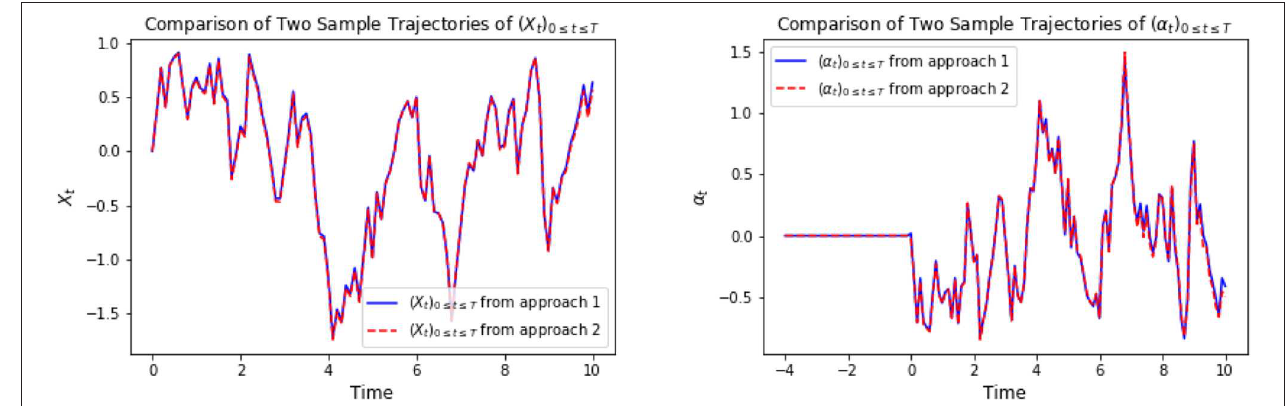
) t . The plot on the right show the comparison of one representative optimal i 0 ≤ t i ≤ t N